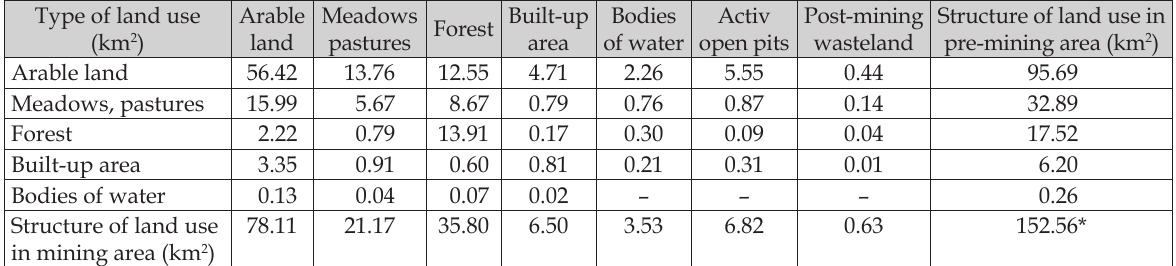
Table 2. The land use transition matrix in 1940-2011, the Adamów-Koźmin mining area. Type of land use